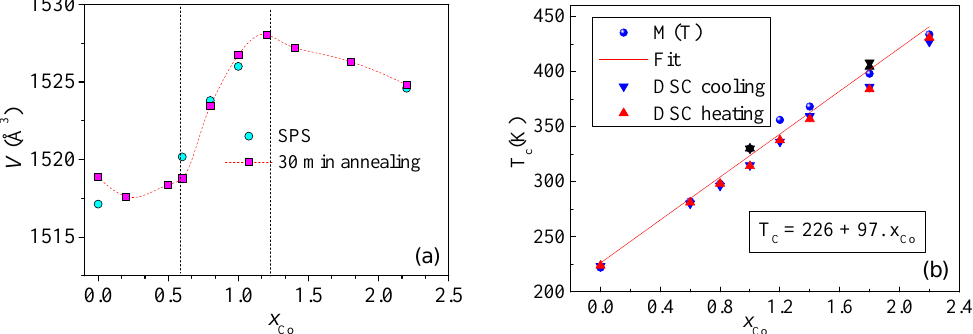
Figure 4. ( a ) Unit cell volume vs. Co content, ( b ) T C vs. Co content, for LaFe 11.5 − x Co x Si 1.5 [52].